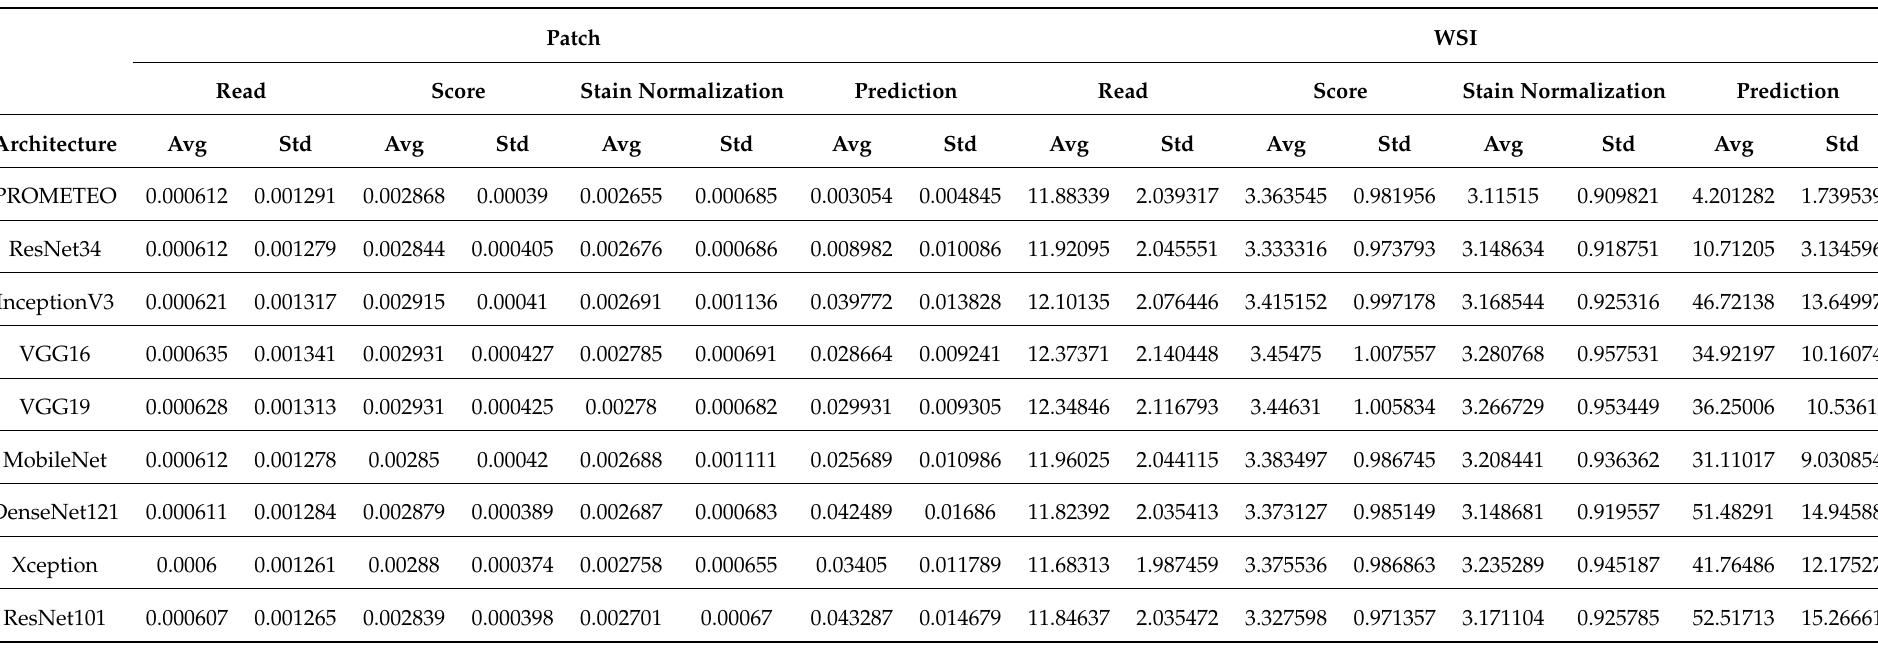
Table A3. Execution time comparison between different architectures. The average (Avg) and standard deviation (Std) of the execution times (in seconds) are shown for each of the